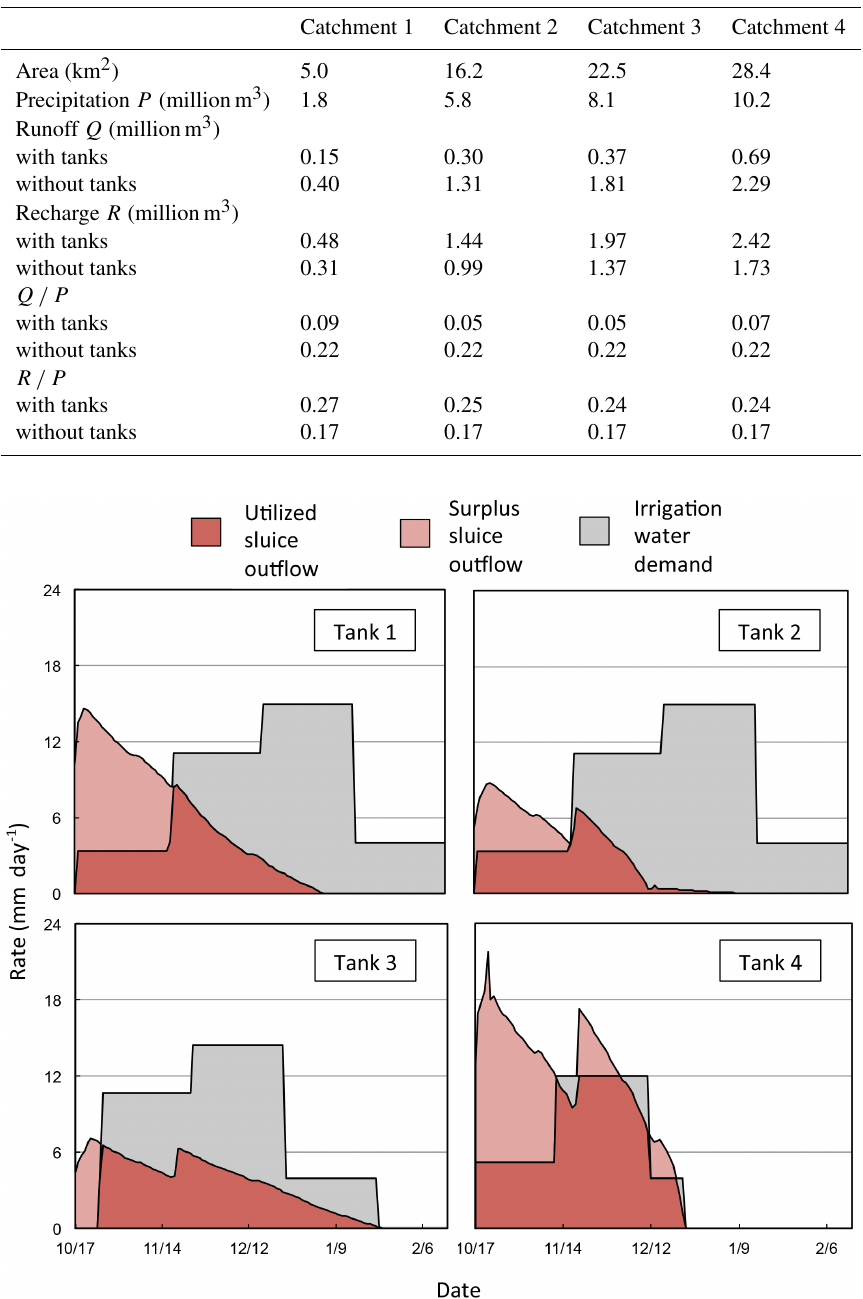
Table 4. Water balance summary at the tank catchment scale.